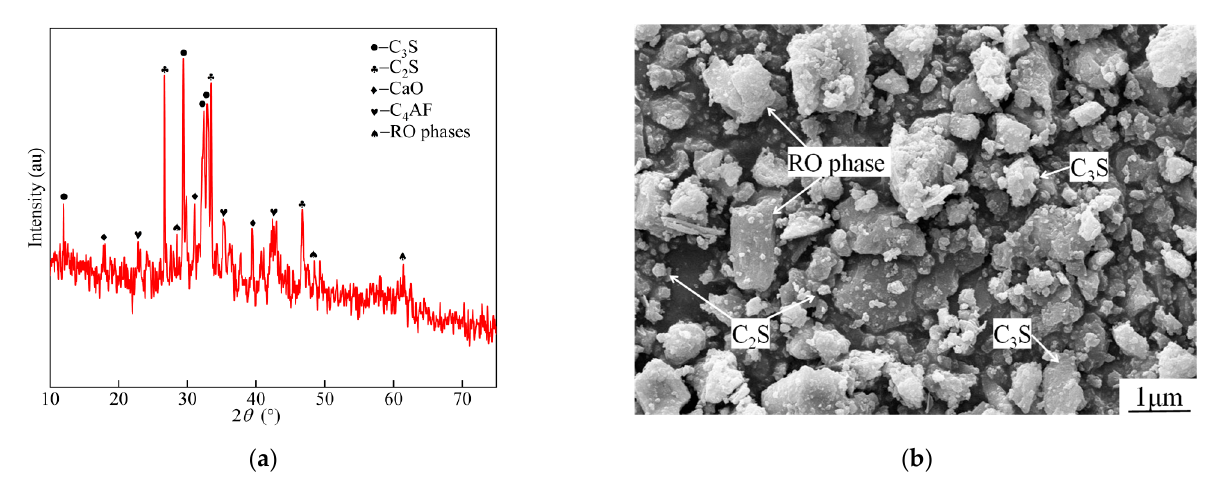
Figure 1. Steel slag physical properties analysis: ( a ) XRD and ( b ) SEM. Table 2. Factor codes and